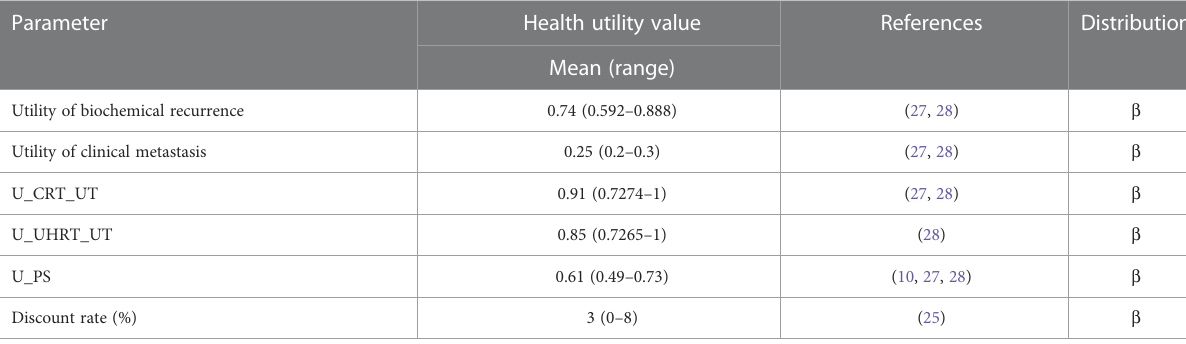
TABLE 2 Summary of model parameters and assumptions.